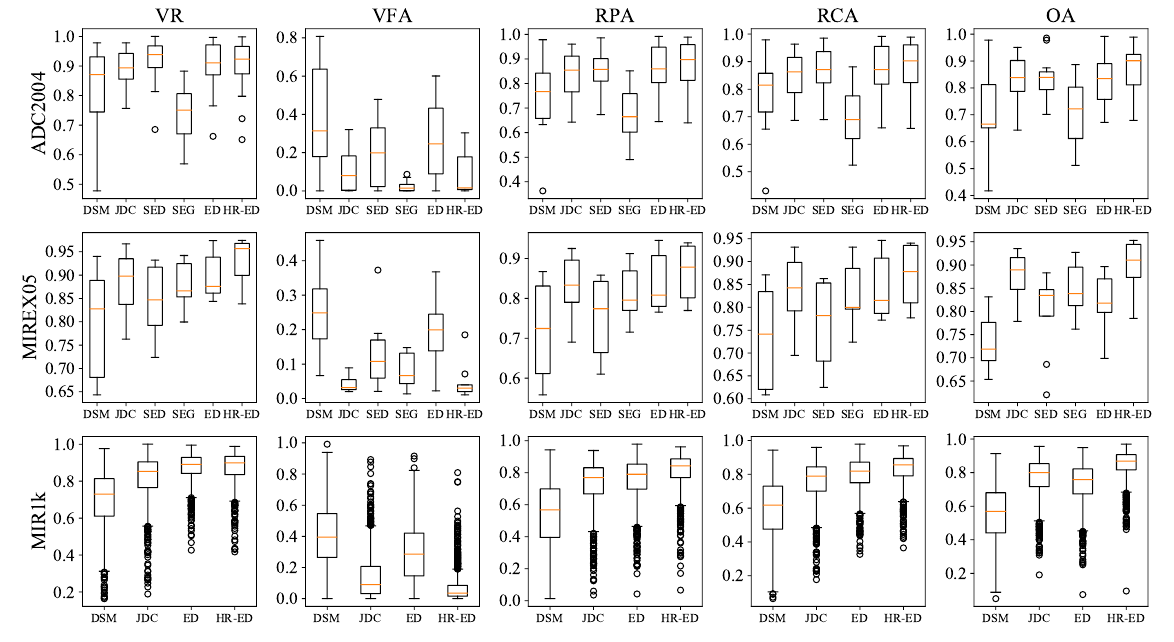
Figure 9. Statistical comparison of vocal melody extraction methods on three public